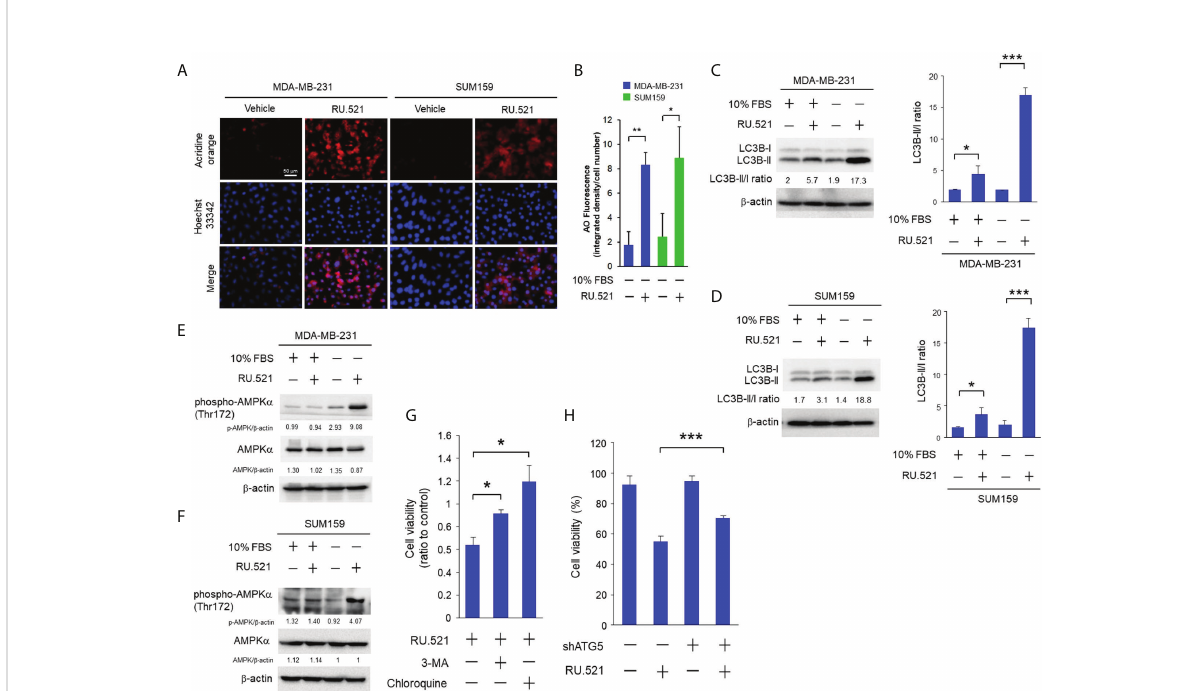
FIGURE 4 RU.521 induced cell death by autophagy in TNBC cells cultured in serum-depleted media. (A) , MDA-MB-231 and SUM159 cells were treated with RU.521 at 10 m M and 8 m M, respectively, in serum-depleted media for 48 hr. Cells were then stained with acridine orange and the red fl uorescence signaling were captured by fl uorescence microscopy at 400x magni fi cation. Bar, 50 m m. The nuclei were counterstained by Hoechst 33342 (blue). (B) , The relative fl uorescence intensity was quantitated. The data of three independent biological repeats are shown as means ± SD. *, p < 0.05; **, p < 0.01. Statistical signi fi cance was calculated by Student ’ s t-test. (C, D) , Expression of the LC3B-l and LC3B-ll proteins in MDA-MB-231 (C) and SUM159 (D) was determined by Western blotting analysis with an anti-LC3B antibody (upper panels). b